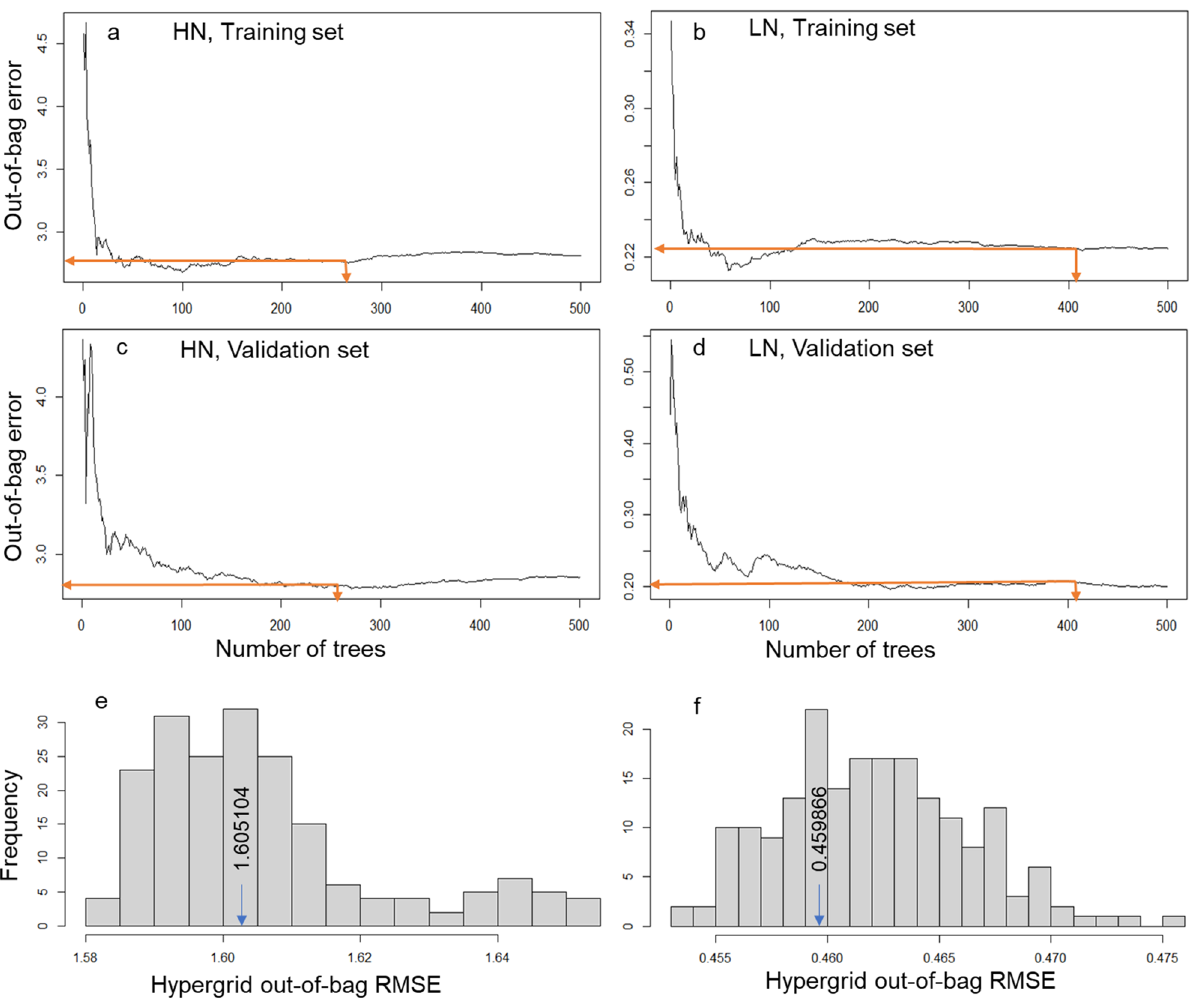
Figure 1. Model training and grid search across 192 hyperparametric combinations. Random forest out-of- bag error rate ( a and b ) compared to the corresponding validation error rate ( c and d ) averaged along tree optimization splits. The optimal number of trees and the corresponding mean squared error (out-of-bag error) are shown by the orange arrows on the graphs ( a – d ). The root mean squared error (RMSE) at which all hyperparameters converged is shown in the histograms ( e and f ). RMSE at optimal hyperparameters (obtained for training model and used for independent validation sets) are shown by arrows in the histograms Also see Supplementary Table S2-tuning